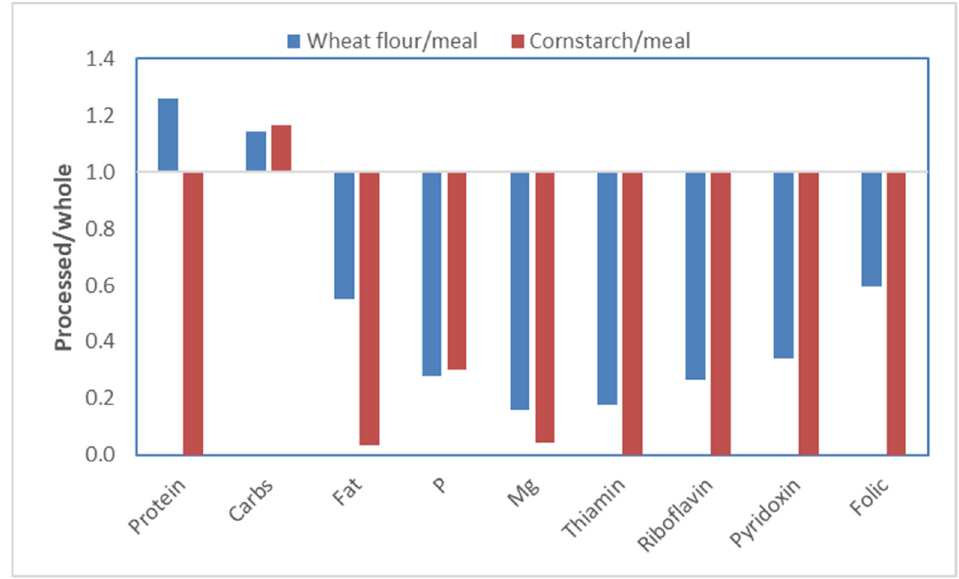
Figure 11. Nutrient content of wheat flour or maize starch compared to whole wheat or maize meal. Data extracted from the NEVO [27] food composition database.